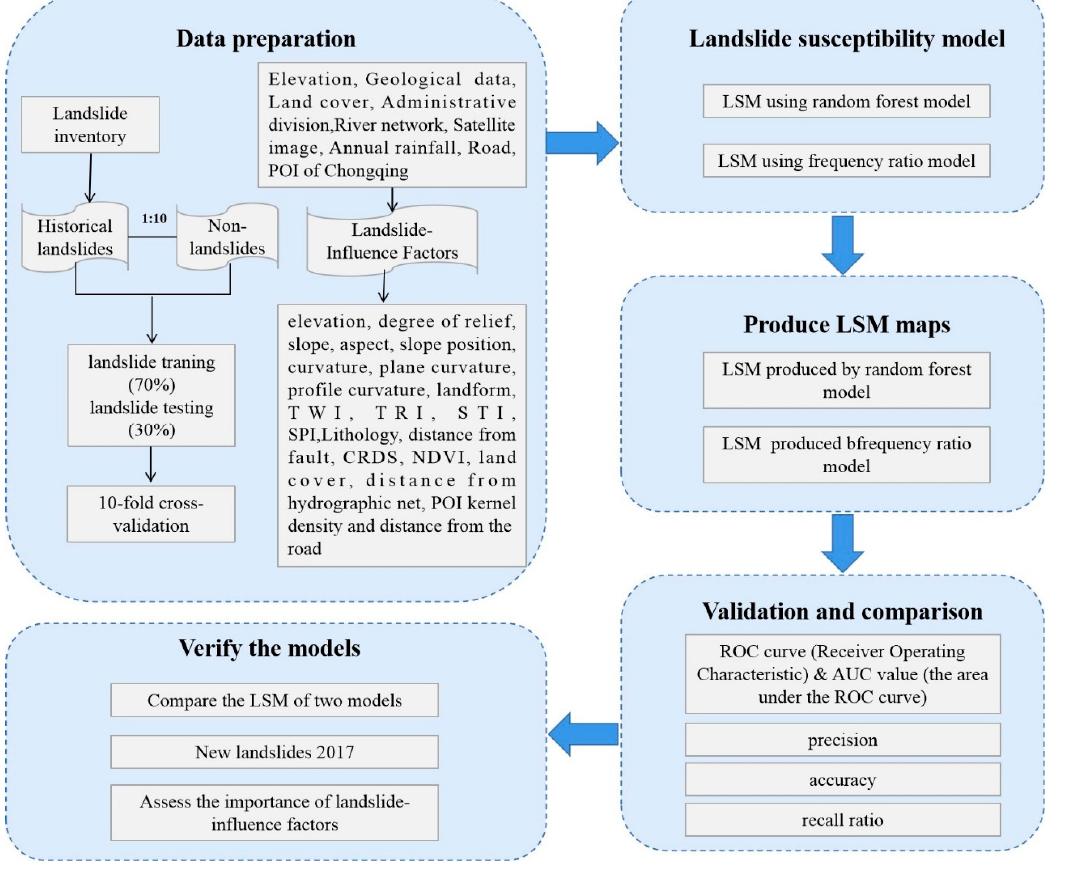
Figure 11. The methodological framework of the study.